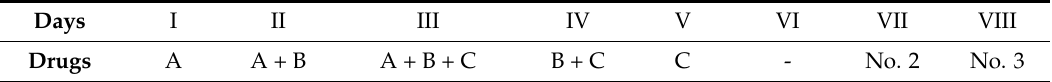
Table 5. Time of administration and time point slaughter for